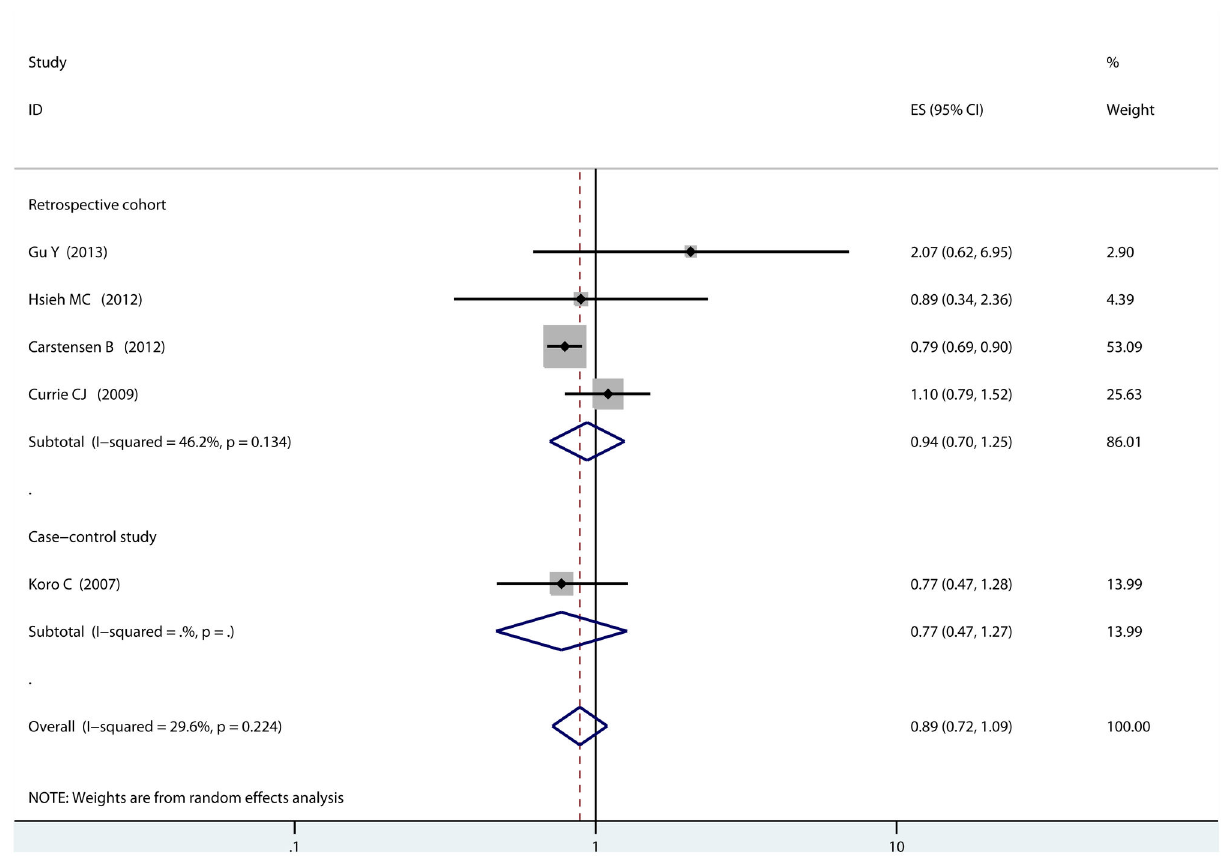
Figure 2. Forest plot: comparison of insulin vs. other glucose-lowering therapies and risk of prostate cancer. doi: